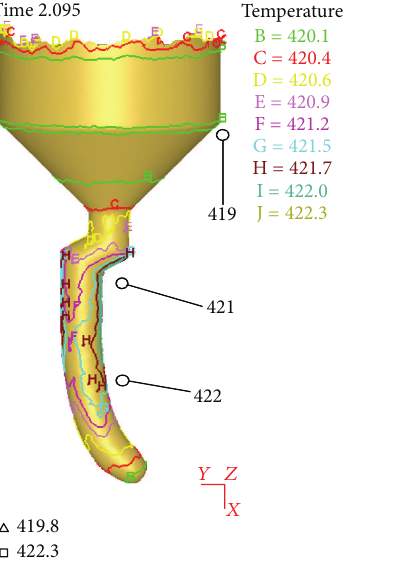
Figure5:Temperaturedistributioninthebilletduringtheextrusion process at the steady stateregime (initial billet temperatureof 420 ∘ C, ram speed of 2mm/s).